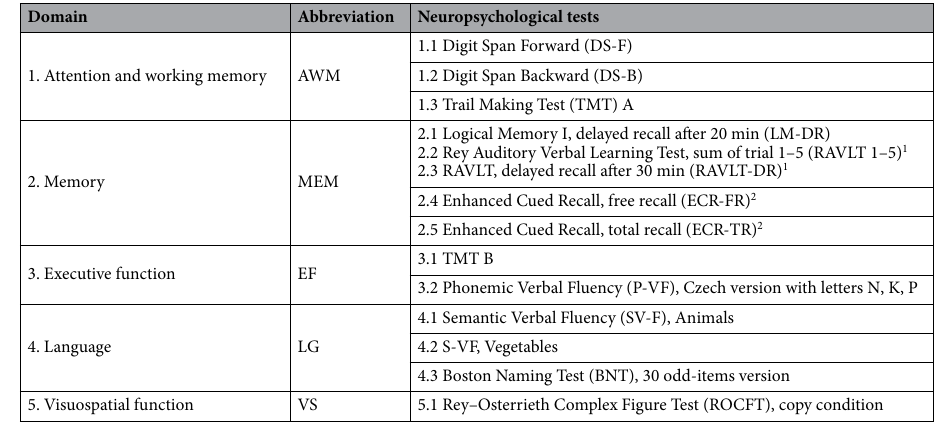
Table 6. Summary of neuropsychological tests according to cognitive domains. 1 Tests that were administered in SCD and aMCI groups only, 2 tests that were administered in DAT (dementia of the Alzheimer’s type) group